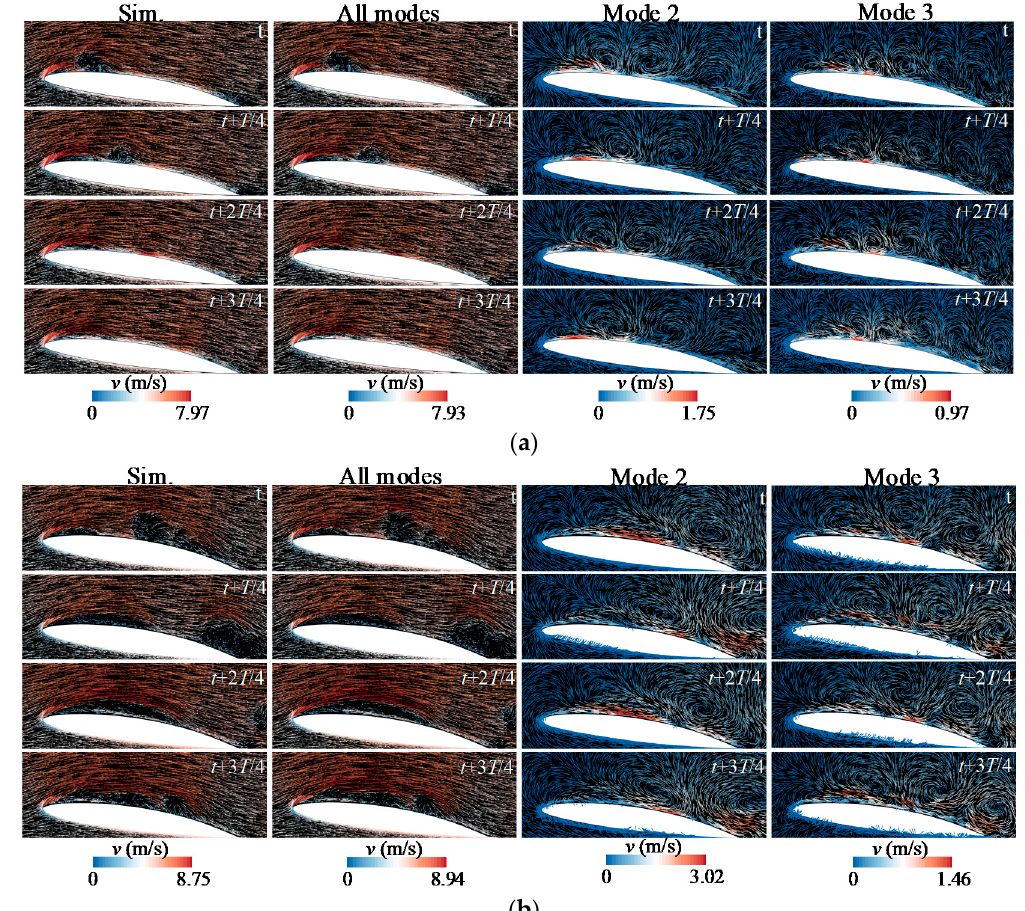
Figure 13. Comparison of the velocity vector of the reconstruction flow field for the near free surface case and no free surface case. ( a ) Velocity vector of the reconstruction flow field for the near free surface case ( h = 0.25 C ); ( b ) The velocity vector of the reconstruction flow field for the no free surface case.